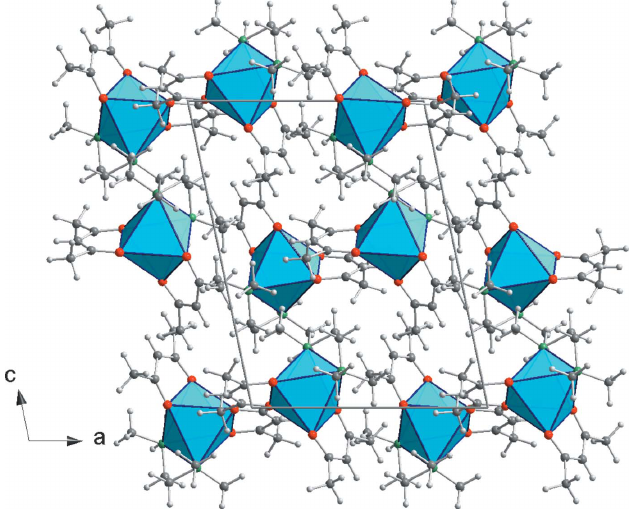
Figure 2 Packing diagram for [Mg(acac) 2 TMEDA] in a view along [010] with a polyhedral representation around the magnesium(II) atom.